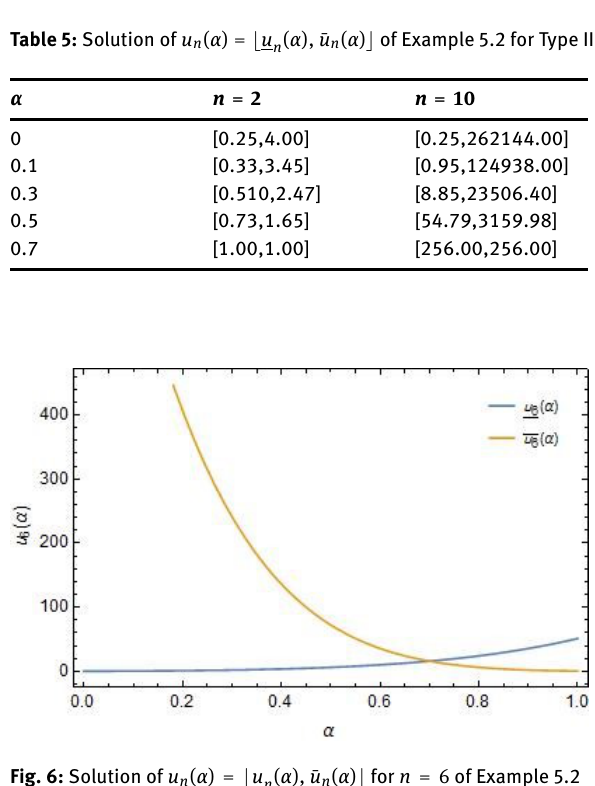
Fig. 6: Solution of u n ( α ) = ⌊ u n ( α ), ¯ u n ( α ) ⌋ for n = 6 of Example 5.2 for Type